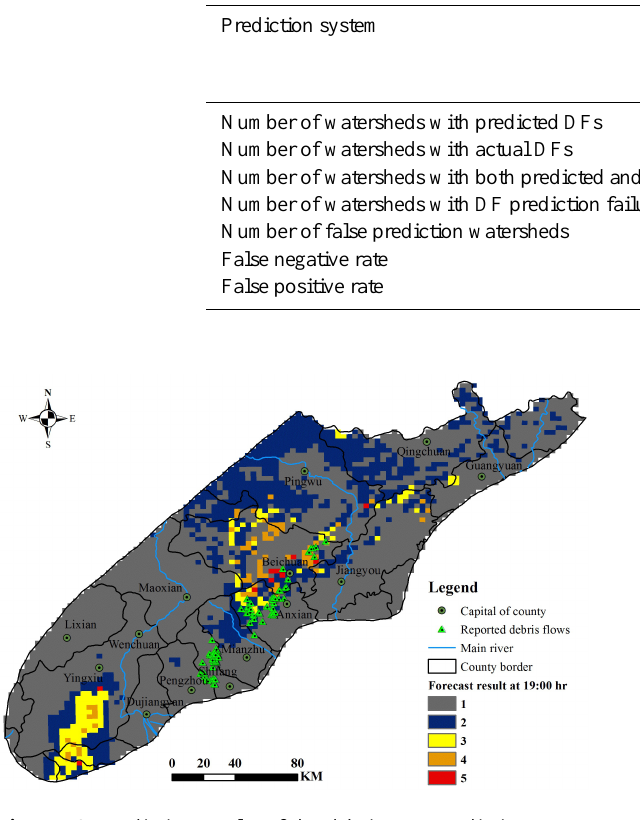
Figure 12. Prediction results of the debris-flow prediction system based on contribution factors.